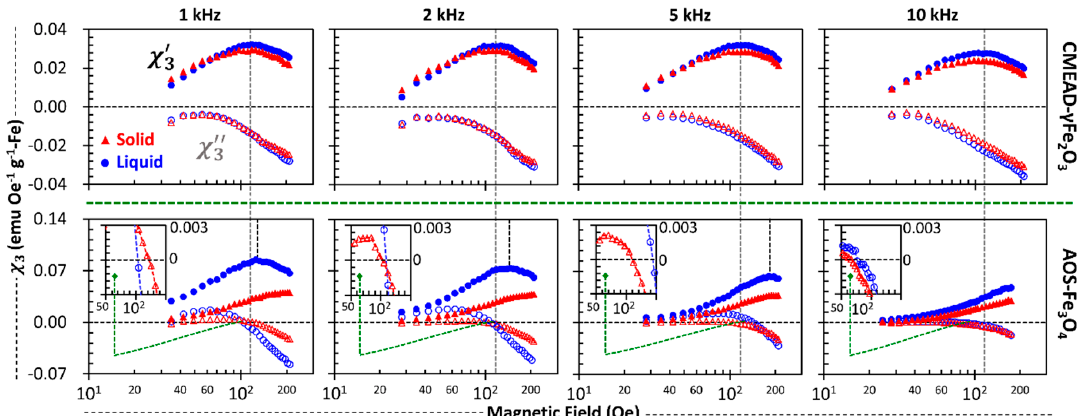
Figure 4. Field-dependent third-harmonic susceptibility at 1, 2, 5, and 10 kHz. The real (cid:2031) (cid:2871)(cid:4593) and the imaginary (cid:2031) (cid:2871)(cid:4593)(cid:4593) parts of the liquid samples (solid and open circles, respectively), as well as those of the solidified samples (solid and open triangles), distinguish the superparamagnetism of CMEAD- γ Fe 2 O 3 nanoclusters from the frequency independence.